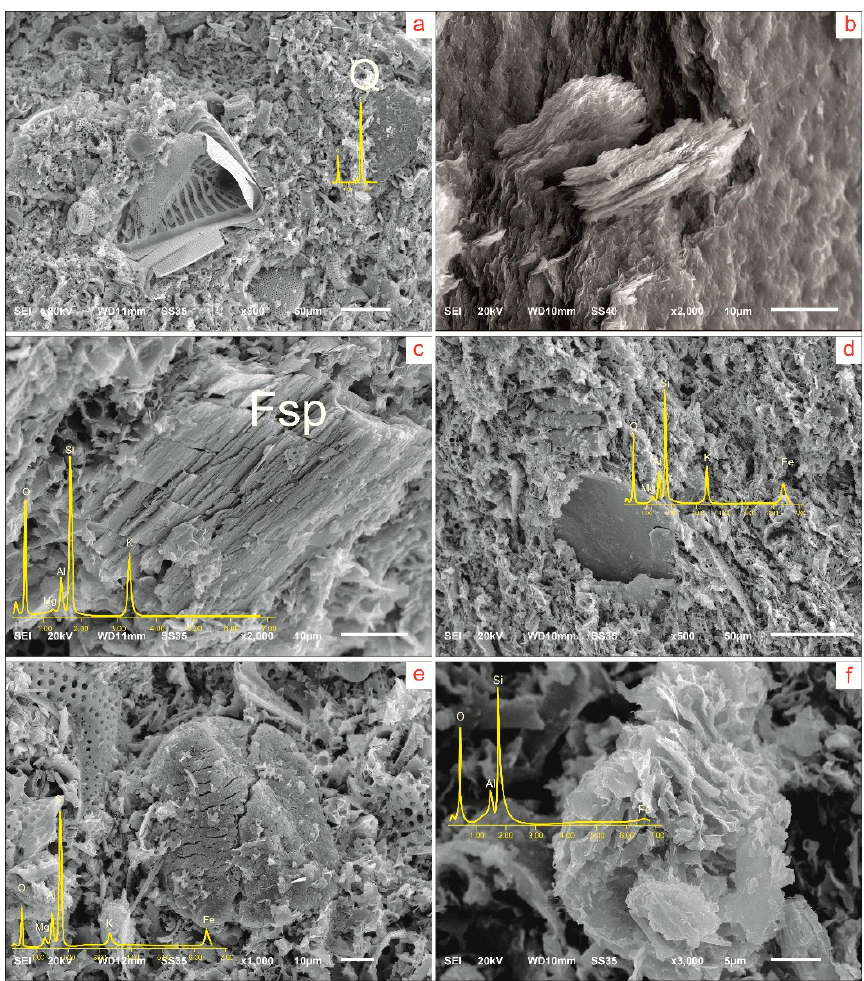
Figure 6. Scanning electron microscopy (SEM) images and Energy Dispersive X-Ray Spectroscopy (EDS) spectra of mineral components: ( a ) bioclastic debris and a single large quartz grain (Q); ( b ) illite, flake-shaped aggregates; ( c ) feldspar with traces of clay minerals formation (Fsp); ( d – f ) clay mineral formations: ( d,e ) illite or illite–smectite minerals; ( f ) kaolinite or kaolinite–smectite mixed-layer minerals